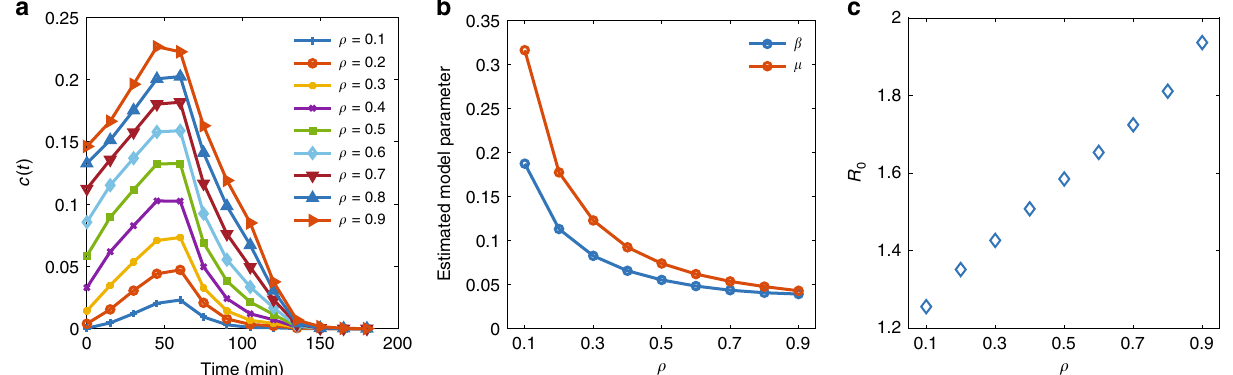
Fig. 5 Spread of traf fi c congestion in Melbourne network. Propagation and dissipation of congestion in the Melbourne network subject to 1-h peak demand, followed by a recovery period with zero demand starting at t = 60 min: a evolution of fraction of congested links in the network over time for different values of ρ , b estimated model parameters β and μ for various ρ , c sensitivity of R 0 to ρ . Here, R 0 > 1 suggests that congestion is spreading for every value of ρ >